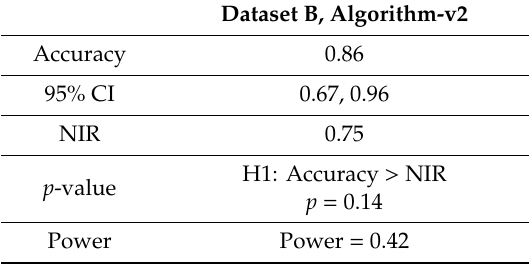
Table 4. Results of the classifier performance assessment. Even though the accuracy was good (second row), not all values within the 95% CI (third row) were above the no information rate (NIR) (fourth row). However, the power of the statistical test was low (sixth row); thus, no firm conclusion could be